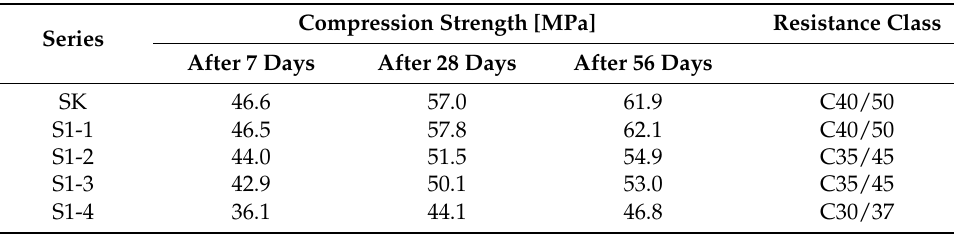
Table 4. Compression strength of the tested concrete and the resistance class.